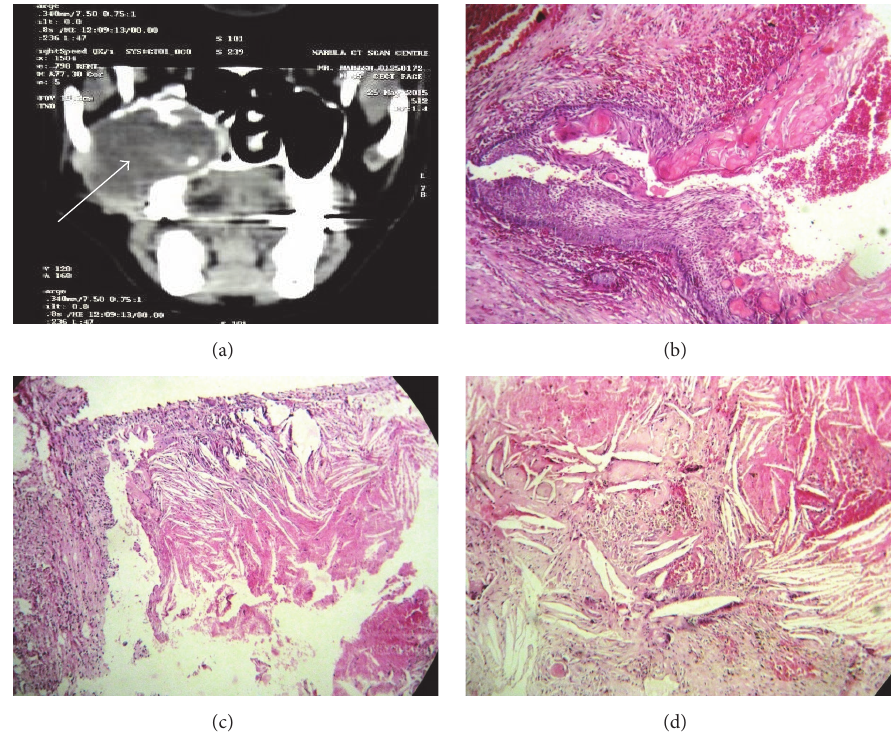
Figure 1: (a) CT scan image showing huge expansile, well demarcated, and osteolytic mass extending from maxilla into the maxillary sinus on right side; (b) proliferation of cystic odontogenic epithelial lining with palisaded hyperchromatic columnar nuclei, stellate reticulum like areas, and sheets of abundant ghost cells (H/E 4x); (c) cholesterol clefts in cystic wall (H/E 4x); (d) cholesterol clefts in cystic wall (H/E